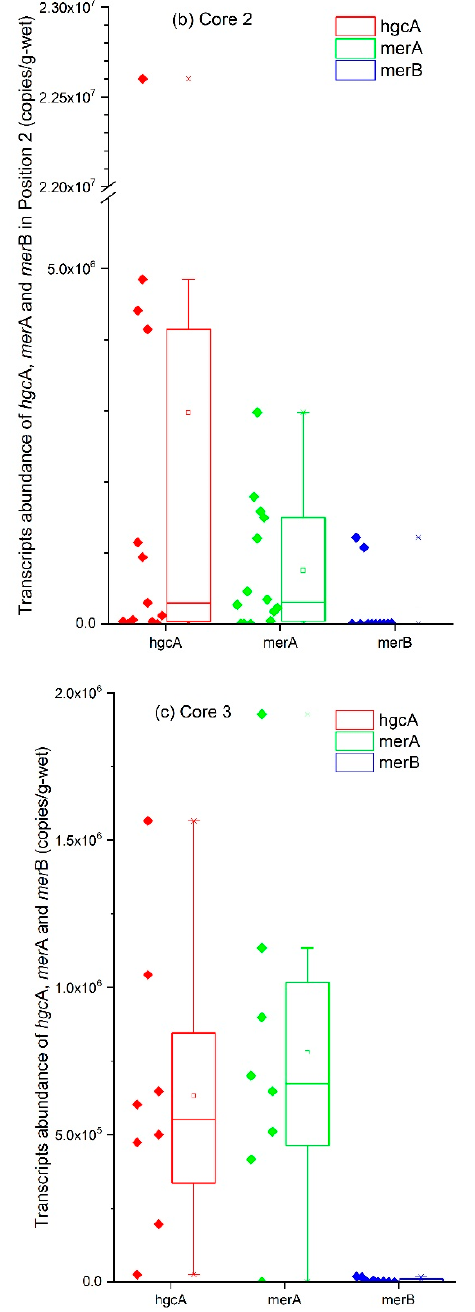
Figure 4. Whisker and box plot representation of the hgcA, merA and merB genes in three sampling cores. ( a ) box plot of hgcA, merA and merB in Core 1; ( b ) box plot of hgcA, merA and merB in Core 2; ( c ) box plot of hgcA, merA and merB in Core 3.